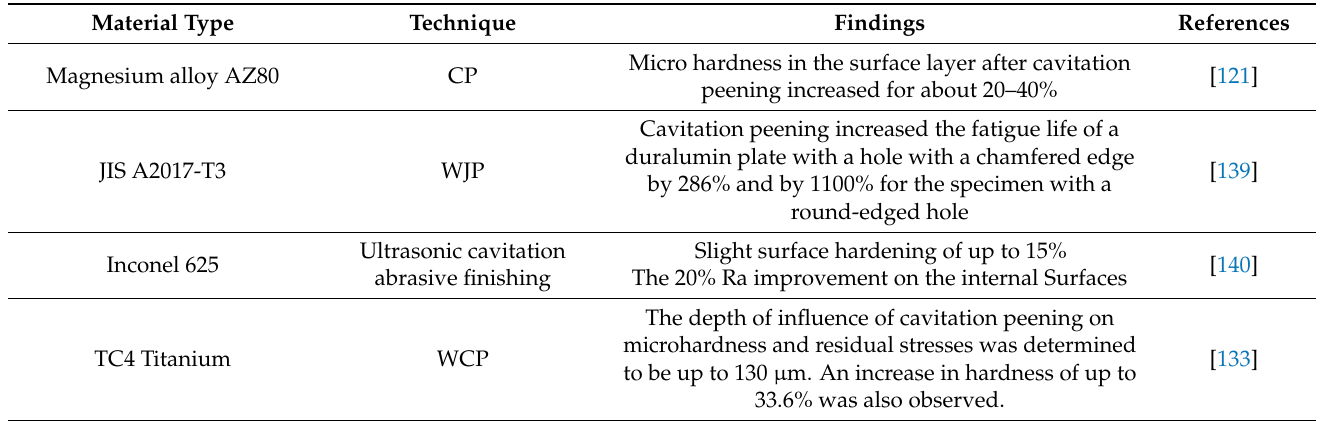
Table 3. Effects of CP on materials properties and